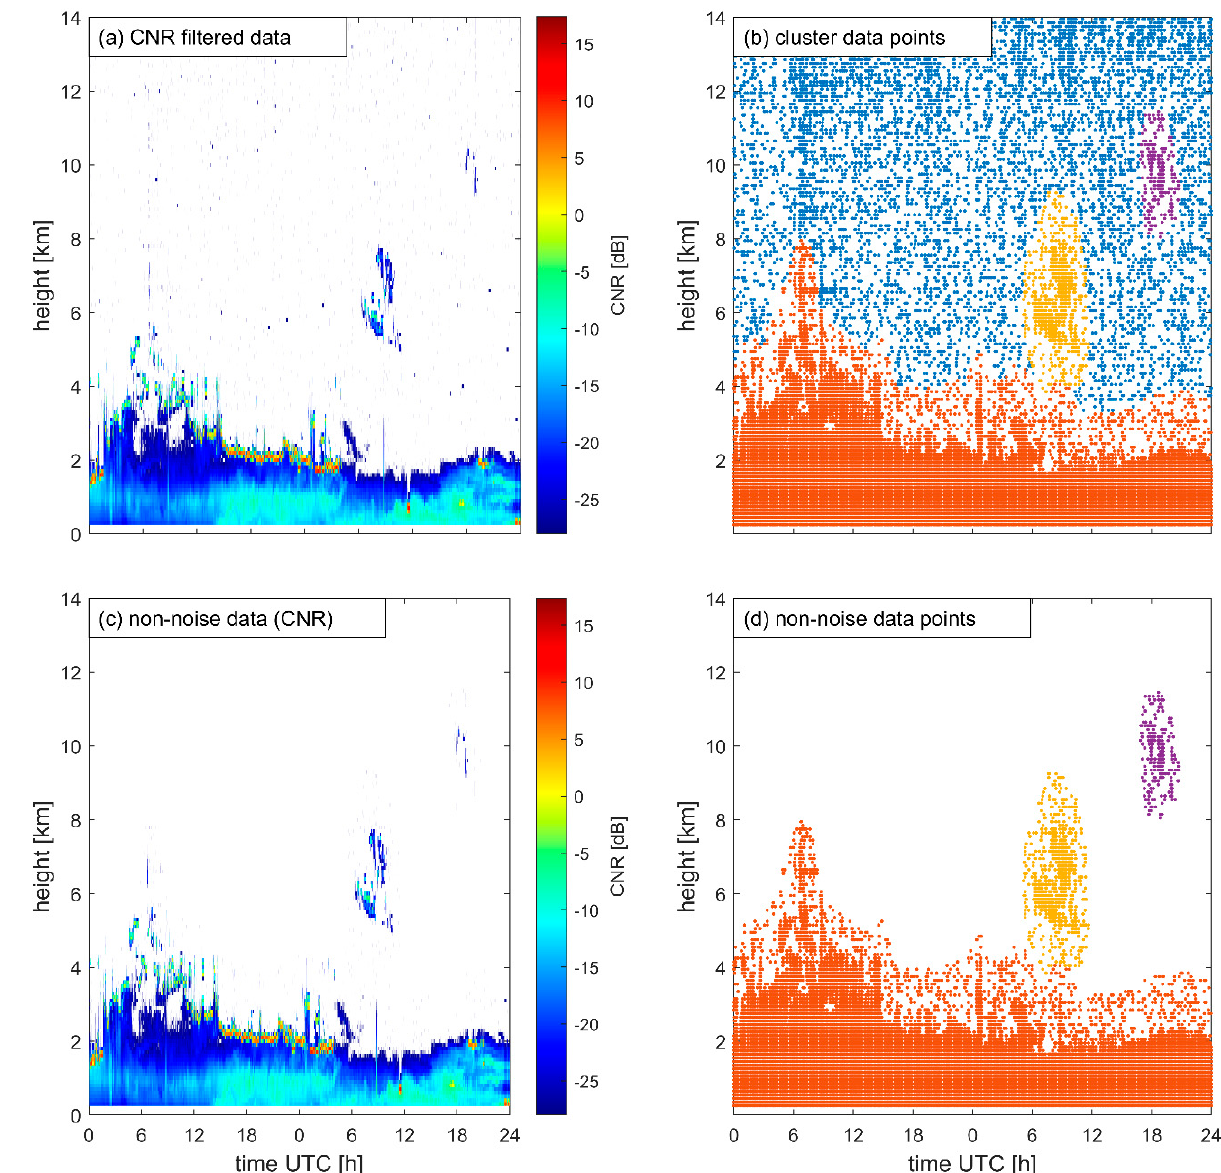
Figure 1. Preparing data for training the noise discrimination model with the DBSCAN clustering algorithm. The left panel ( a , c ) is the CNR data, while the right panel ( b , d ) is the clustered data points. All data were collected on 31 July and 1 August 2019. ( a ) CNR > − 28 dB; ( b ) same data as in ( a ), but the colors indicate the data groups clustered by the DBSCAN algorithm. Omitting the considered noise data (blue dots in ( b )), the filtered data are shown in ( c , d ). The yellow and purple groups are considered as clouds far above the boundary layer, labeled as high clouds for training the classification model; the orange group is clustered as the same group and considered as the non-noise measurements, which will be further classified later. The x-axis shows the time of 31 July and 1 August 2019.